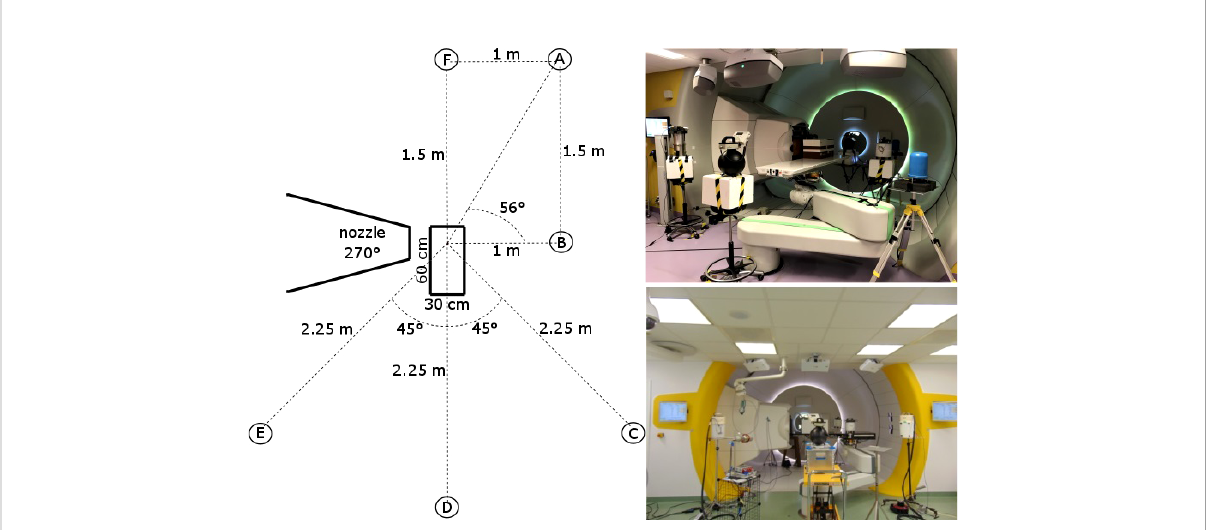
FIGURE 1 Schematic representation of the setup and the measurement positions (left), picture of the measurements at Skandion (right top), and picture of the measurements at CCB (right bottom).